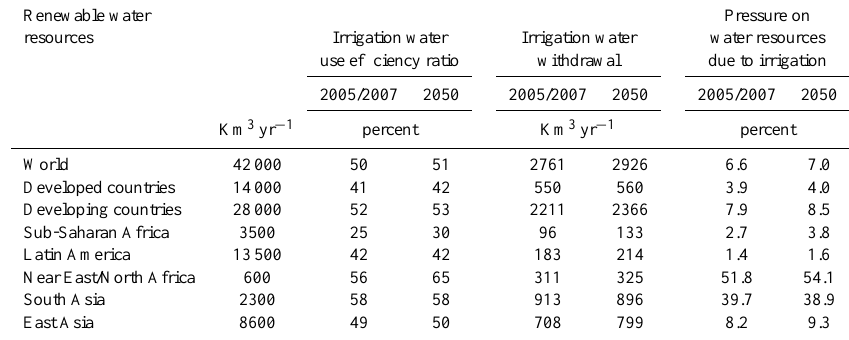
Source: FAOSTAT and AQUASTAT. Table A12. Annual renewable water resources and irrigation water withdrawal. Renewable